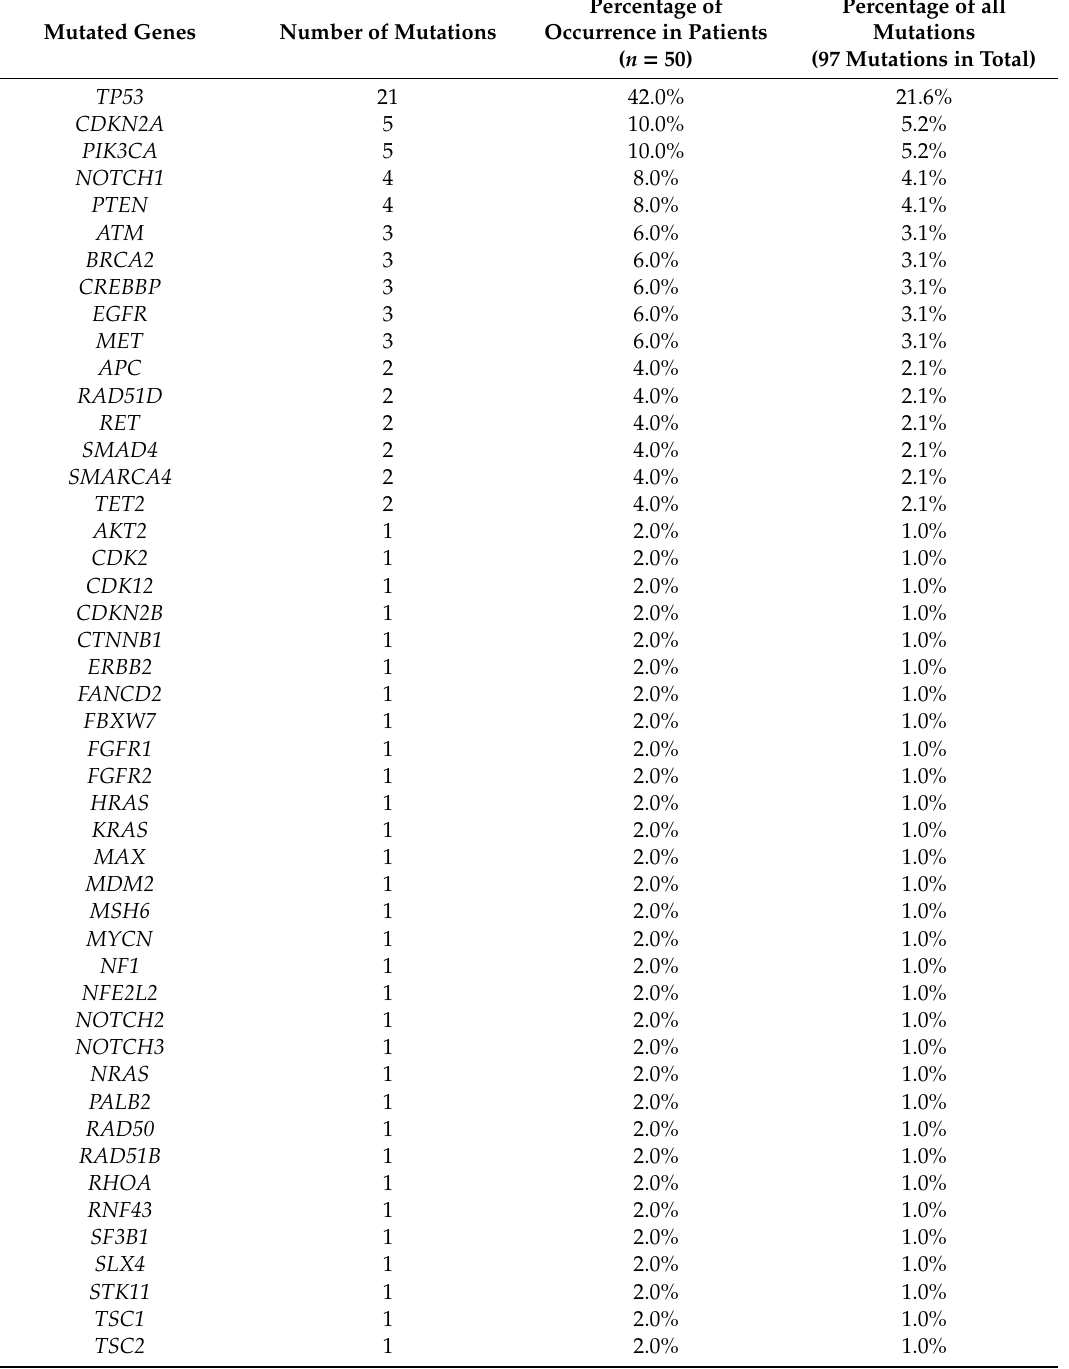
Table 2. Genomic profile of the recurrent / metastatic head and neck cancer (R / M HNC) patients. Mutated Genes Number of